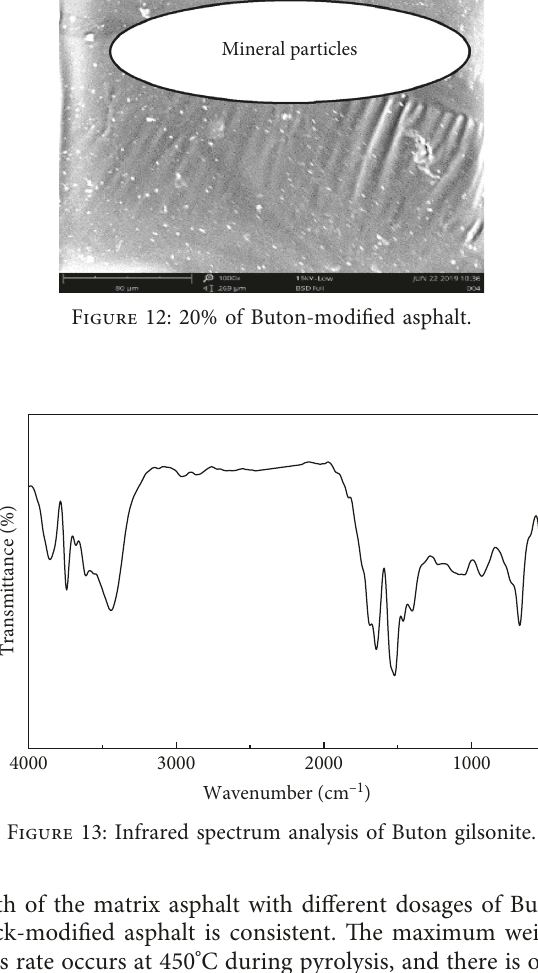
Figure 8: Comparison of antiaging properties of modified asphalt with different gilsonite contents.